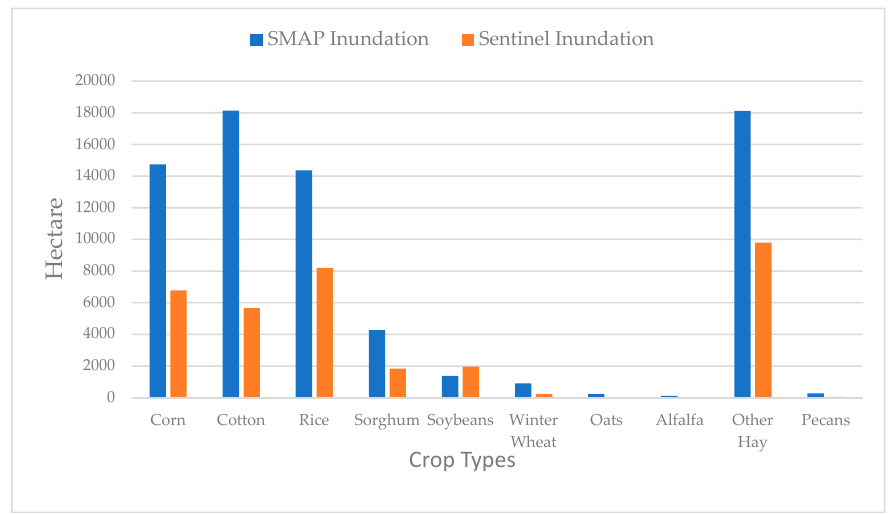
Figure 5. Comparison of SMAP and Sentinel-1 derived inundation acreage of the Houston Flood over major crop types.